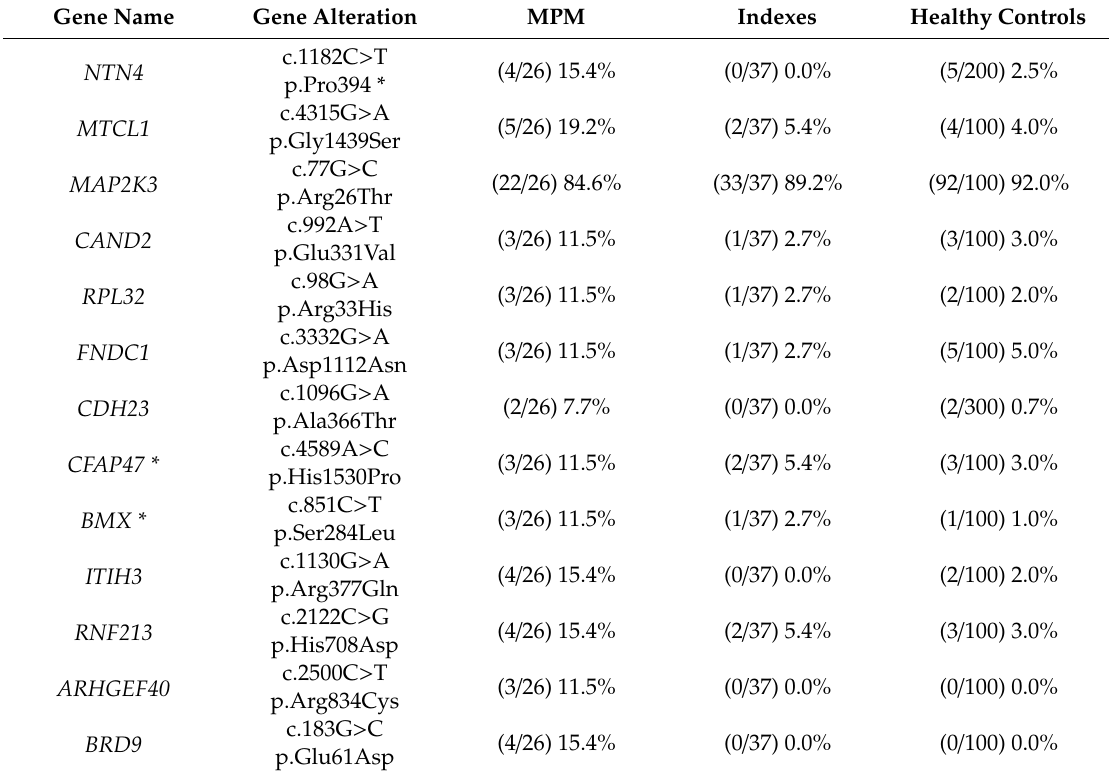
Table 1. Candidate gene variants frequency. List of the frequency of candidate variants by screening against 26 MPM patients and 33 familial melanoma index cases, as well as their frequency in the Portuguese population by screening against 100 healthy